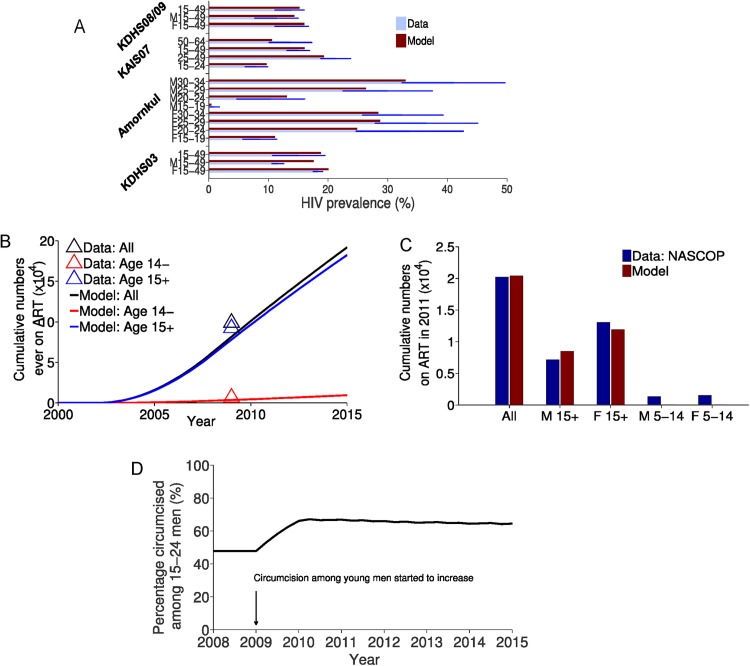
Calibration of model parameters using epidemiological and behavioral data from Nyanza.A) Calibration of model uncertain parameters using age-gender-specific prevalence data at different years from Kenya's KDHS 2003 and 2008/09 and KAIS 2007 surveys [17,53,54] and a published report by Amornkul et. al. [55]. Dark blue lines indicate confidence intervals of prevalence data. Prevalence values among males and females of various age intervals are indicated with M and F otherwise no indication for values among all adults of that age. Calibration to B) age-specific data on numbers ever initiated treatment up to 2009 as reported in NASCOP 2009 report [46], and to C) age-gender-specific data on numbers ever initiated treatment during 2011 from NASCOP [42]. Calibrations in B) and C) are used to adjust proportion initiating treatment at CD4 = 350 and at CD4≤250 cells/mm3 in fitted case (estimated at 10% and 90% of those with CD4≤350 cells/mm3, respectively). D) Assumed baseline male circumcision coverage among young men representing recent increase in proportion of young males (age 15–24) getting circumcised in Nyanza [46,54,56,57] (incorporated in the fitted case and all scenarios).